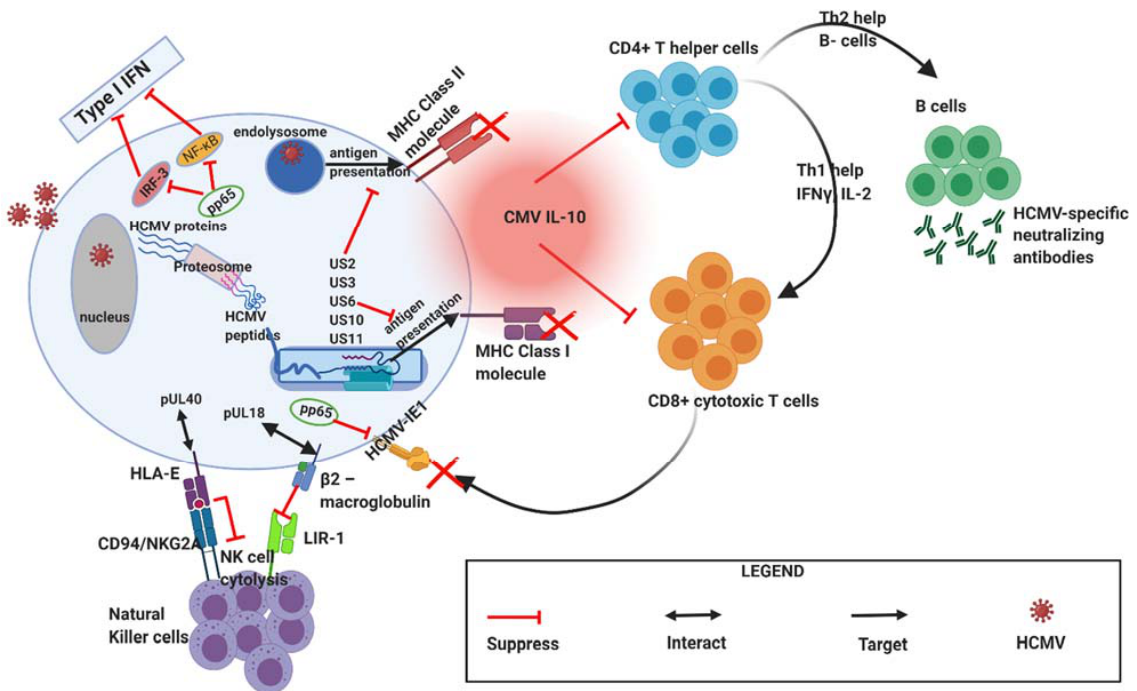
Figure 2. During primary infection, HCMV employs various mechanisms to mediate immune evasion. HCMV expresses viral genes and proteins that interfere with host interferon responses (pp65), inhibit natural killer cell recognition or activation (pUL40 and pUL18), inhibit CD4+ and CD8+ T-cell recognition by preventing MHC Class I and II antigen processing and presentation (e.g., US2, US3, US6, US10, US11). CMV IL-10 (viral IL-10 homologue) produced by infected cells further acts to suppress CD4+ and C8+ T cell responses. HCMV, human cytomegalovirus; MHC, major histocompatibility complex